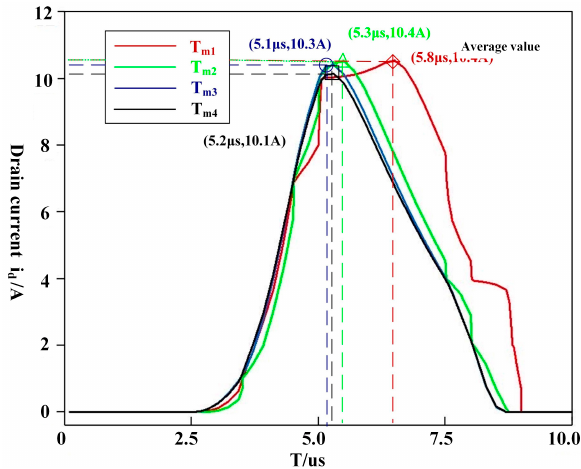
Figure 14. Simulation curves of i d and T m1 /T m2 /T m3 /T m4 . 4. Joint Simulation of Multiple Parasitic Parameters in the Double-Pulse Test Circuit The simulation object is the extreme value of the multiple parasitic parameters on r Δ i during the joint simulation process. The joint simulation circuit of multiple parasitic pa- rameters is designed, as shown in Figure 15.